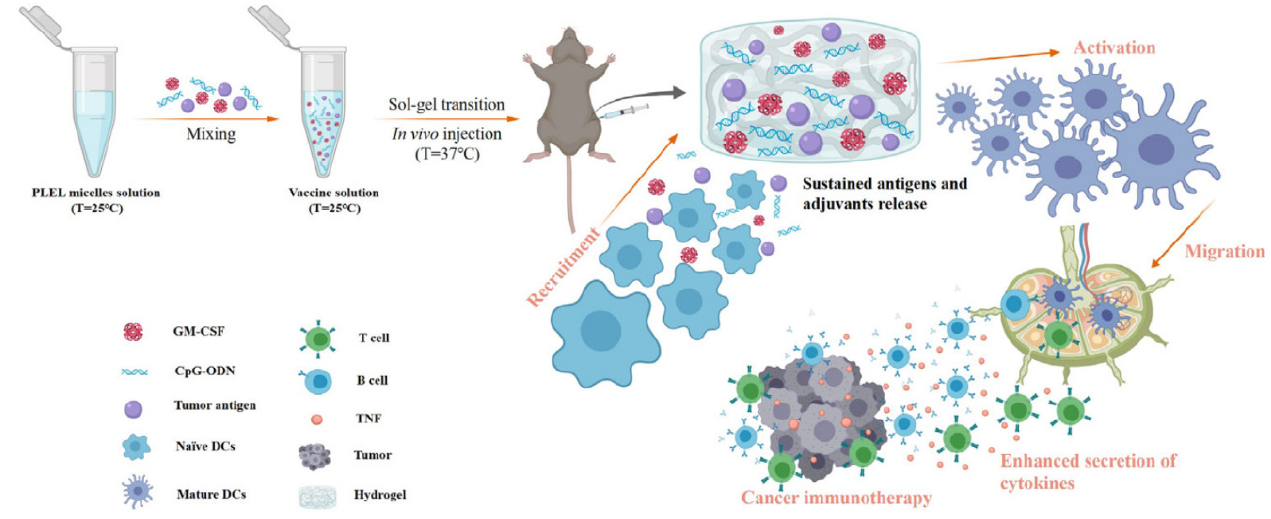
Figure 3. In vivo immune regulation mediated by the hydrogel vaccine. Reprinted with permission from Elsevier [47].